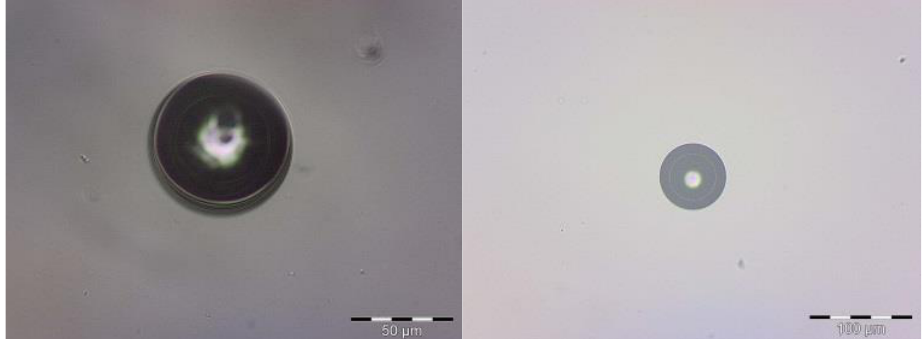
Figure 1. Optical micrographs of chitosan microcapsules.